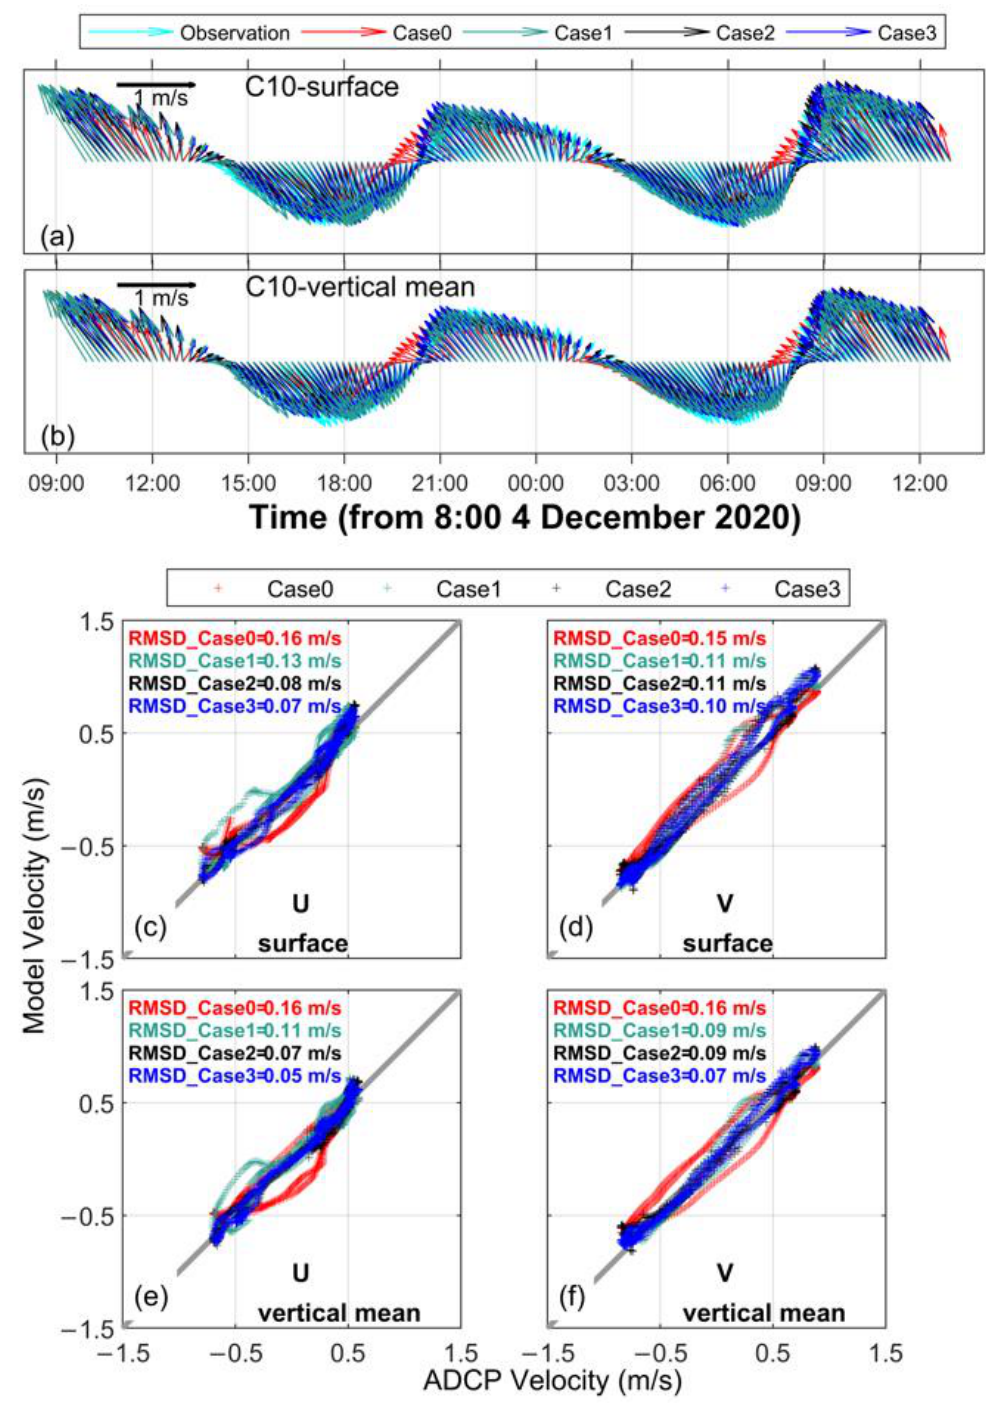
Figure 5. Vector plots of ( a ) the surface and ( b ) vertical mean currents. ( c – f ) Relationship between ADCP and model velocities at C10. U and V indicate the eastward and northward velocity compo- nents, respectively. Table 3. Model accuracy at C10.